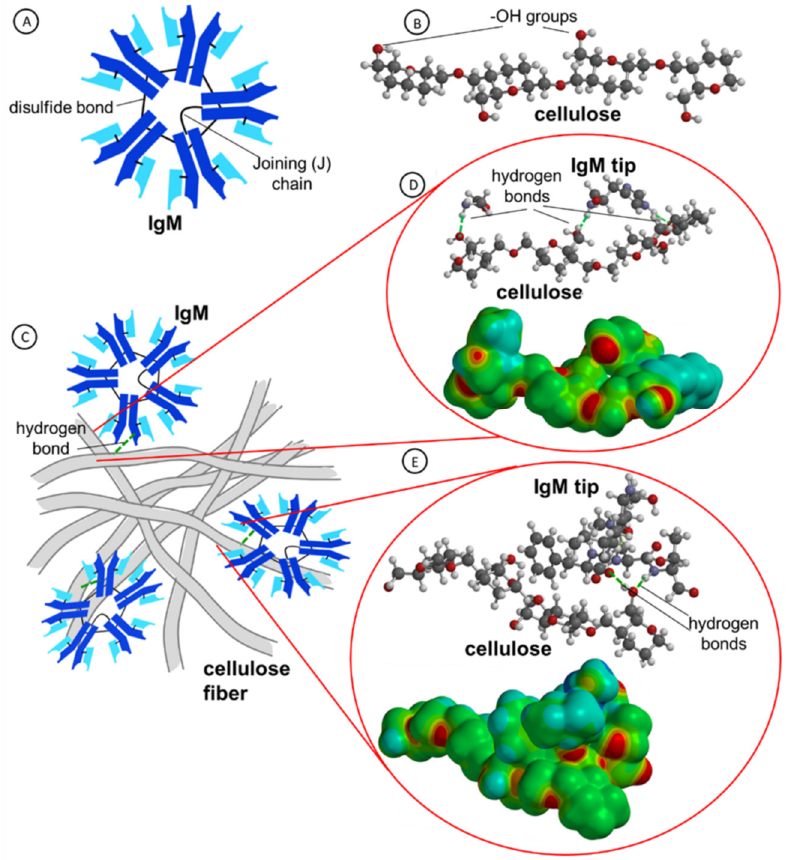
Figure 4. Structures and supramolecular interactions of IgM antibody with cellulose fibrils. ( A ) Schematic view of IgM structure; ( B ) structure of a cellulose chain with exposed -OH groups (red—O atoms, blue—N atoms, dark grey—C atoms, and light grey—H atoms); ( C ) cartoon of interactions of antibodies with a net of cellulose fibers; ( D , E ) molecular dynamics simulation of supramolecular interactions of cellulose with model amino acids ( D ) and a sequence of five amino acids (-SER-ILE-PHE-LEU-THR-) representing the IgM antibody tip: (Bottom panels) electron density surfaces of cellulose and amino acids (d = 0.002 a.u.) mapped with electrostatic potential; electrostatic potential color coding: from negative-red to positive-blue.